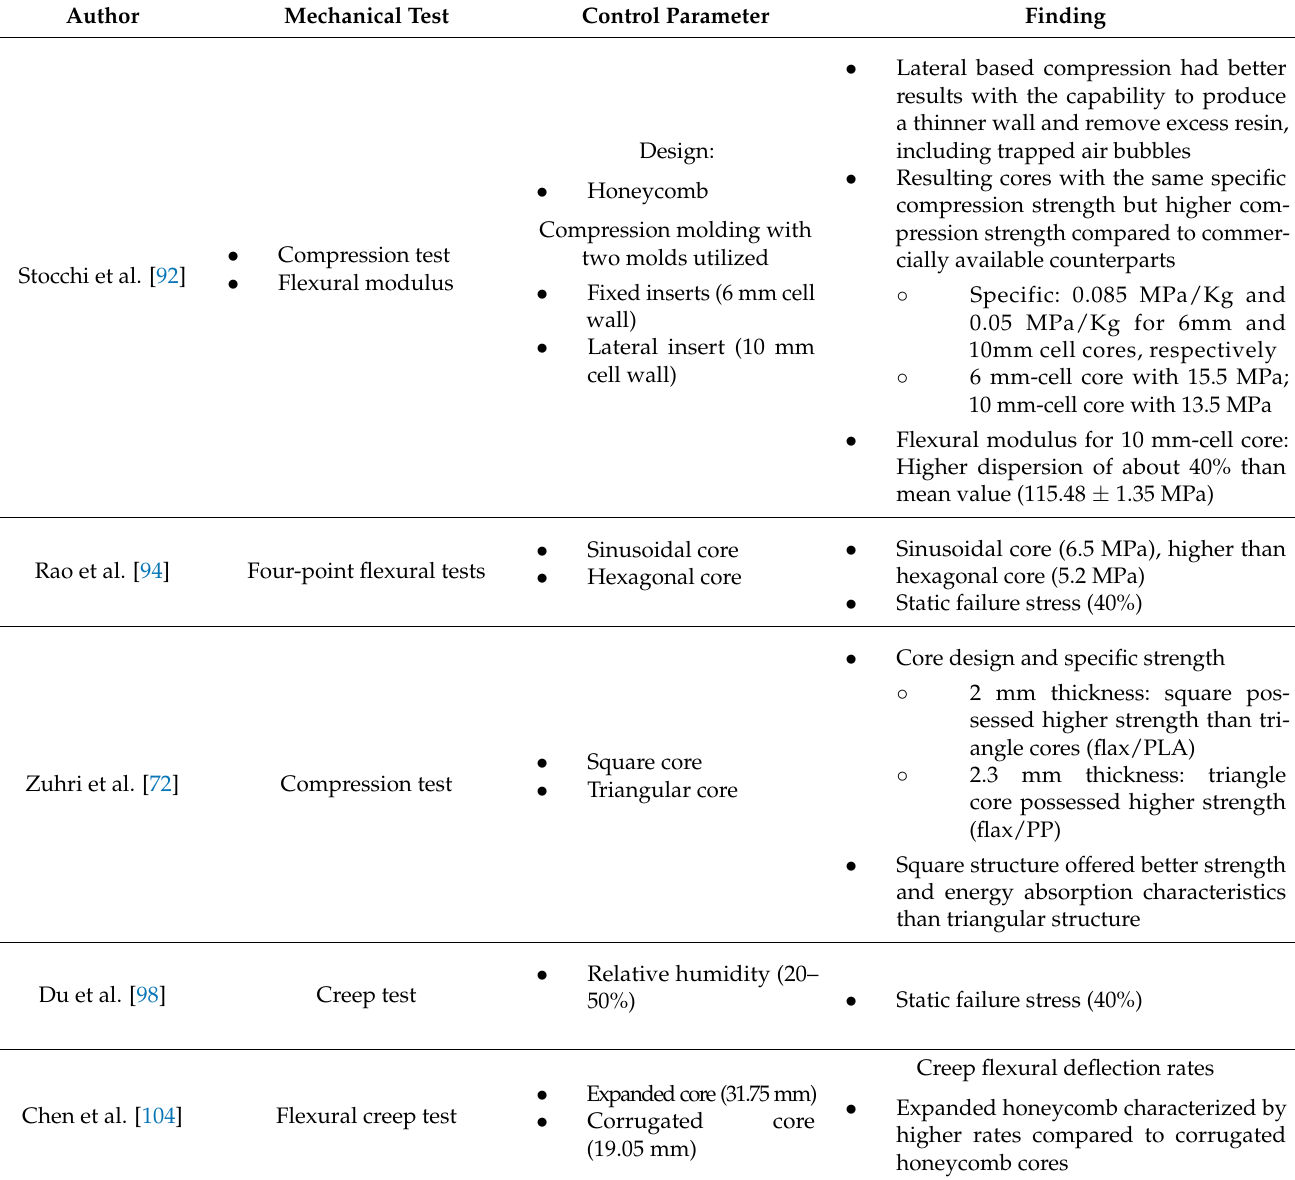
Table 5. Summary of selected papers on natural fiber based core